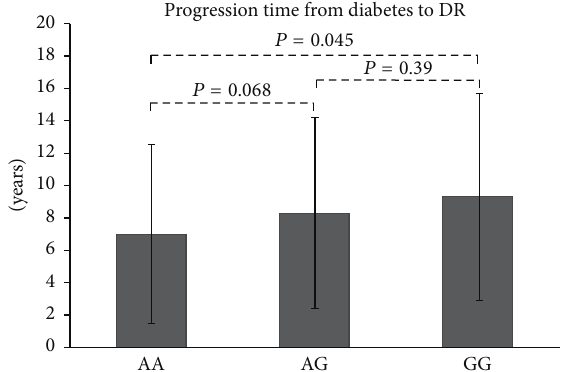
Figure 2: The average time of progression from diabetes to DR according to genotype. AA: 7.0 ± 5.5; AG: 8.3 ± 5.9; GG: 9.3 ± 6.4